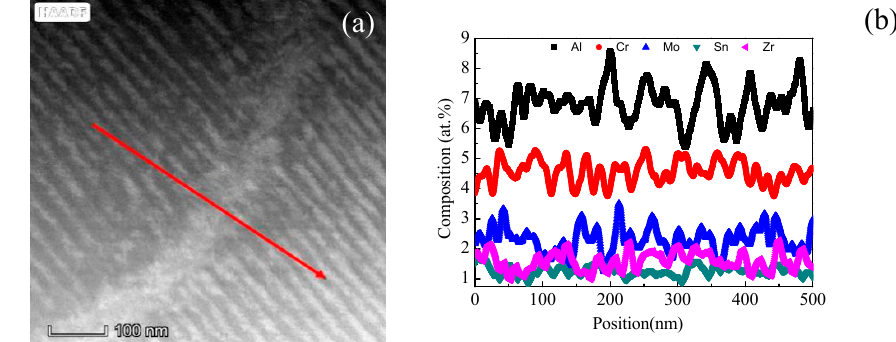
Figure 6. Microstructure in the sample heated to 1178 K: ( a ) HAADF and ( b ) composition profiles along the red line in ( a ).